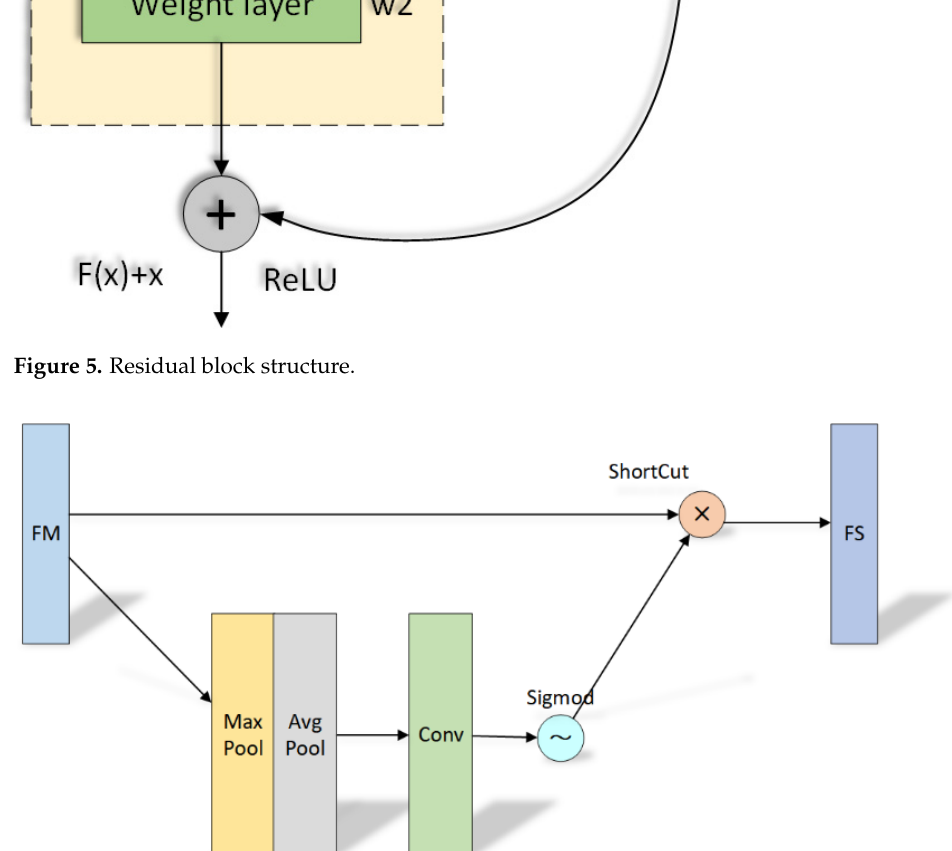
Figure 7. Add attention mechanism based on SAM module (the red box is the improved part). 3.3. K-Means Algorithm Improves the Prior Size of the Target Prediction Candidate Box The improved YOLOv3-Tiny model follows the idea of a preset anchor box, sets 9 anchor boxes as target prediction candidate boxes and clusters the target types in the data set through the clustering algorithm to obtain the scale size of the target preselection box. As a classical clustering algorithm, the k-means algorithm is widely used because of its simplicity and efficiency. The k-means algorithm is sensitive to the selection of initial seed